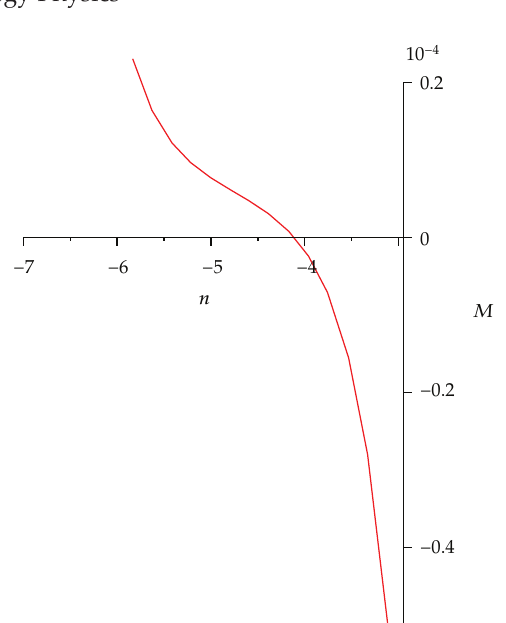
Figure 2: Stability of the de Sitter phase. The de Sitter phase is stable for n (cid:3) − 4 .